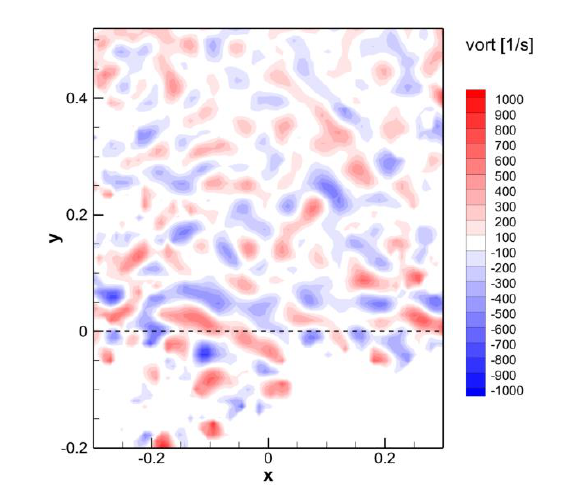
Fig. 20. Example of the instantaneous vorticity field. Re = 1.5M.